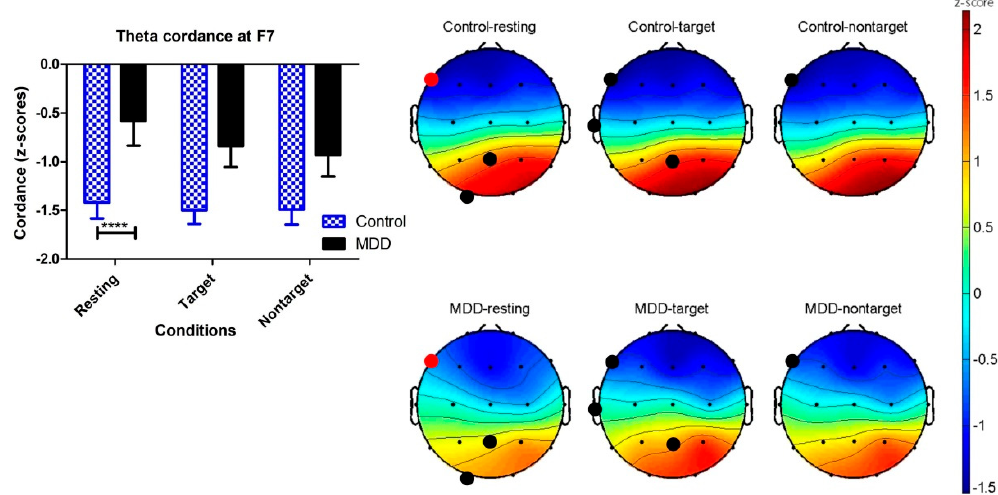
Figure 6. Brain maps of the cordance values (z-scores) in the theta frequency band in the MDD and control groups. Black dots show p < 0.05 electroencephalography (EEG) channels by applying unpaired t-test on the control and MDD groups. Red dots are the location of the EEG F7 channels with significant difference using two-way ANOVA (**** p < 0.0001).